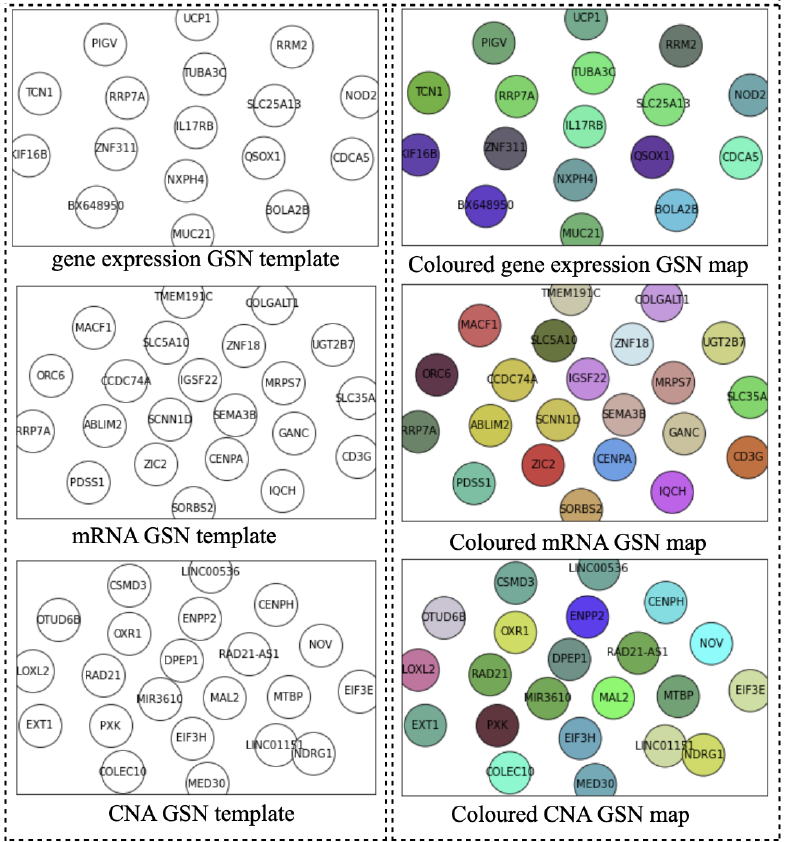
Figure 2. Templates of three omics datasets embedded by t -SNE